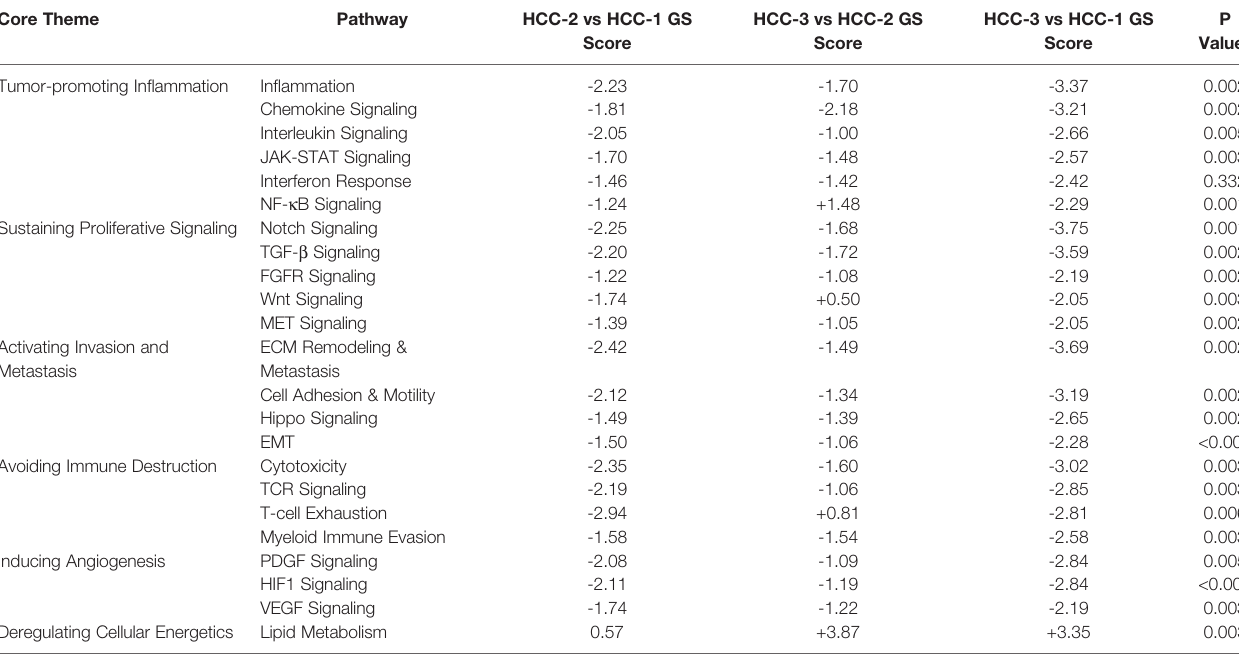
TABLE 2 | Directed global signi fi cance scores of top 20 differentially expressed